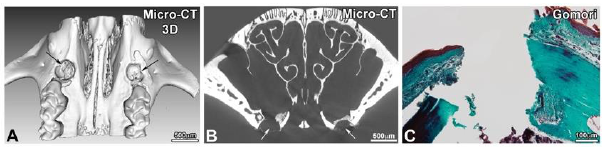
Figure 4. Observation of maxillary bone lesion after 3D reconstruction ( A ) of X-ray microtomography images ( B ) and after histological staining with Gomori trichrome staining ( C ).